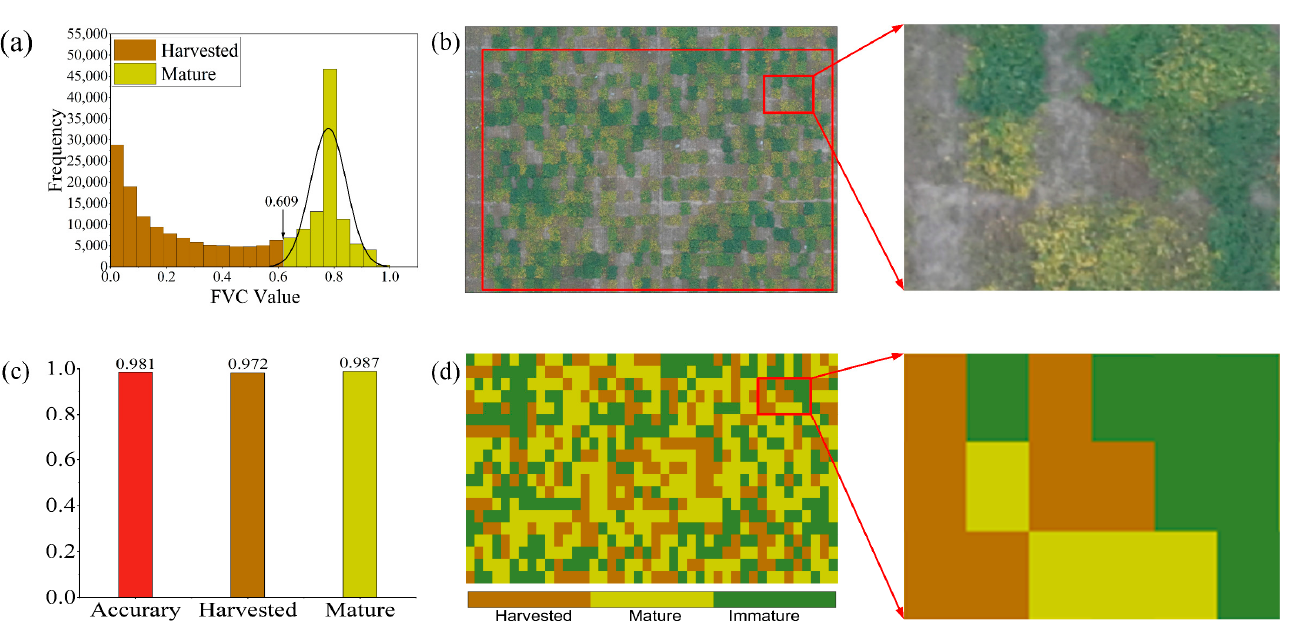
Figure 10g. The results indicate that the LCC maturity soybean thresholds obtained from P3 are feasible for use in P4 soybean maturity monitoring.